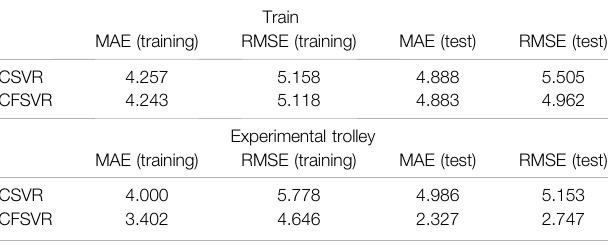
TABLE 4 | Performance of CFSVR and CSVR on antenna signal data.